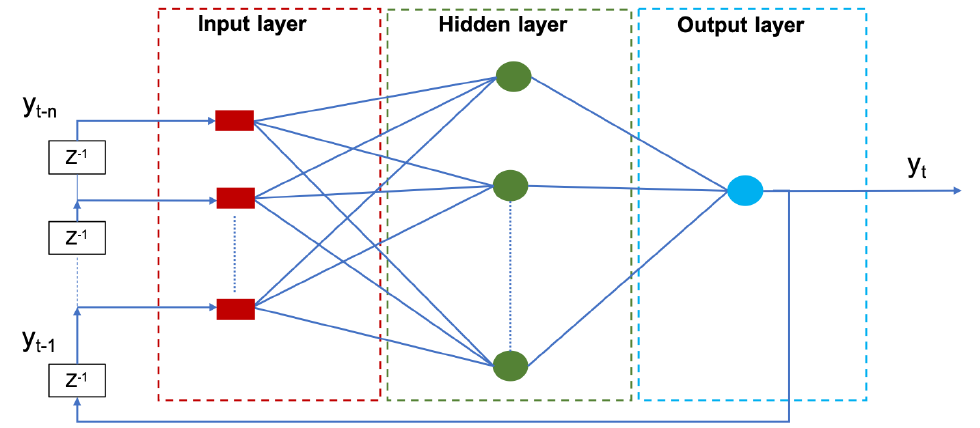
Figure 3. Topology of the Non-Linear Autoregressive